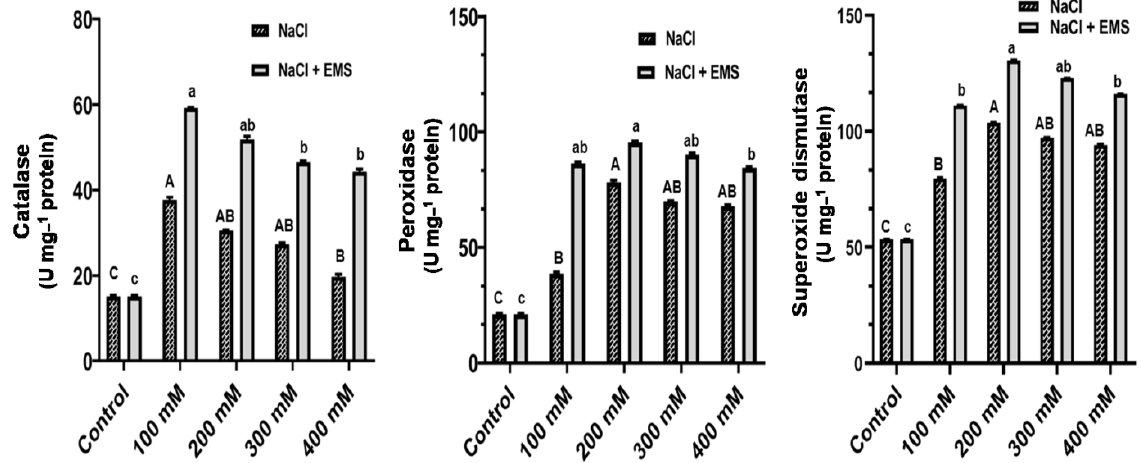
Figure 5. Antioxidant enzymes activities of (CAT, POD, and SOD) on NaCl and ethyl methane sulphonate induced mutation treated on calluses of A. vulgaris. The values reflect the mean ± SE of three repeated experiments. Different letters correspond to a significant difference from each other at ( p ≤ 0.05), according to DMRT. Uppercase for NaCl and lowercase for (NaCl +